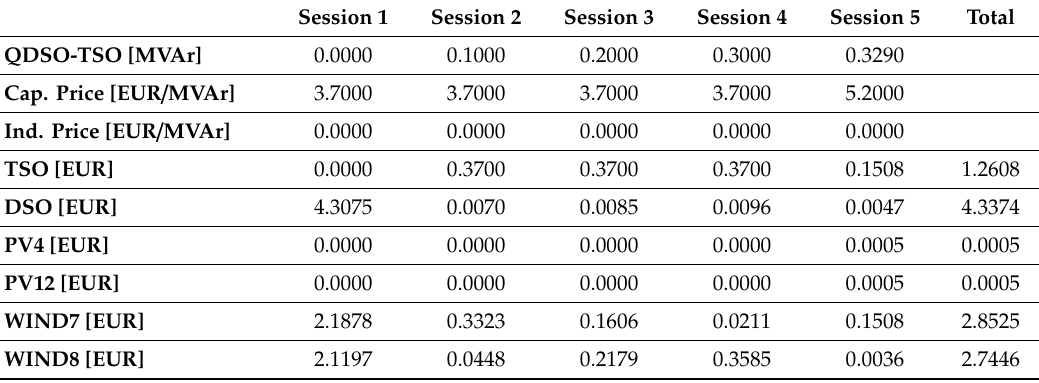
Table 5. Incomes and payments for increasing TSO capacitive needs at each market